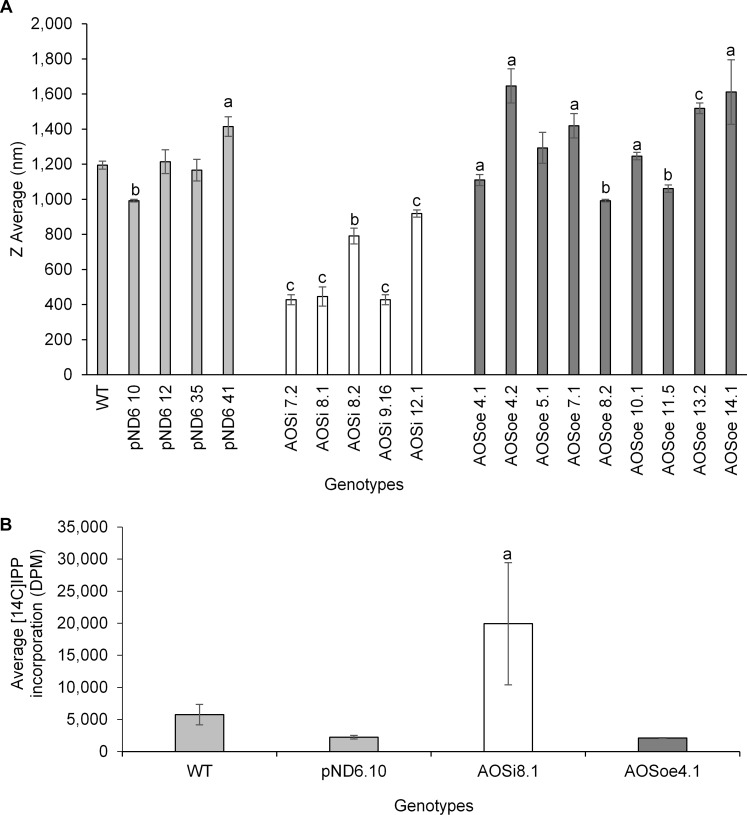
(A) WRP size determination by dynamic light scattering from 1-year old greenhouse-grown WT control and transgenic lines. Statistical significance analysis of the differences was performed with t-test with a, p < 0.05; b, p < 0.005; c, p < 0.0005 relative to the WT. (B)
In vitro [14C]IPP incorporation assay. One mg of WRPs from 1-year old WT control and transgenic lines greenhouse plants was assayed in a final volume of 50 μL. Incorporation of labeled IPP was determined using a scintillation counter. Error bars represent SD from the average of three technical replicates. Data are representative of three independent experiments.